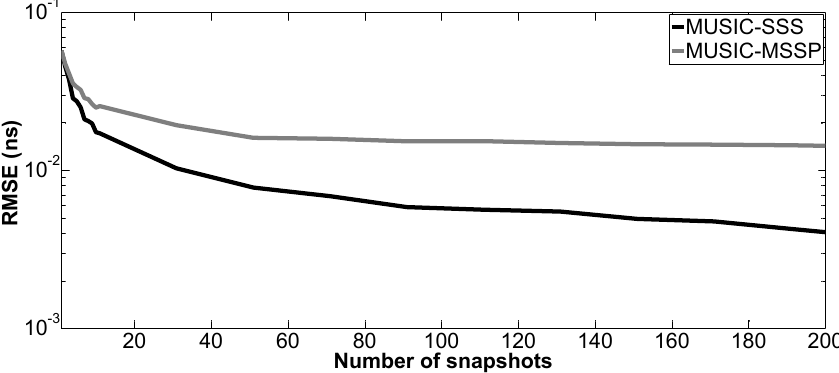
Figure 9. RMSE on the estimated time delay ˆ t 1 versus the number of